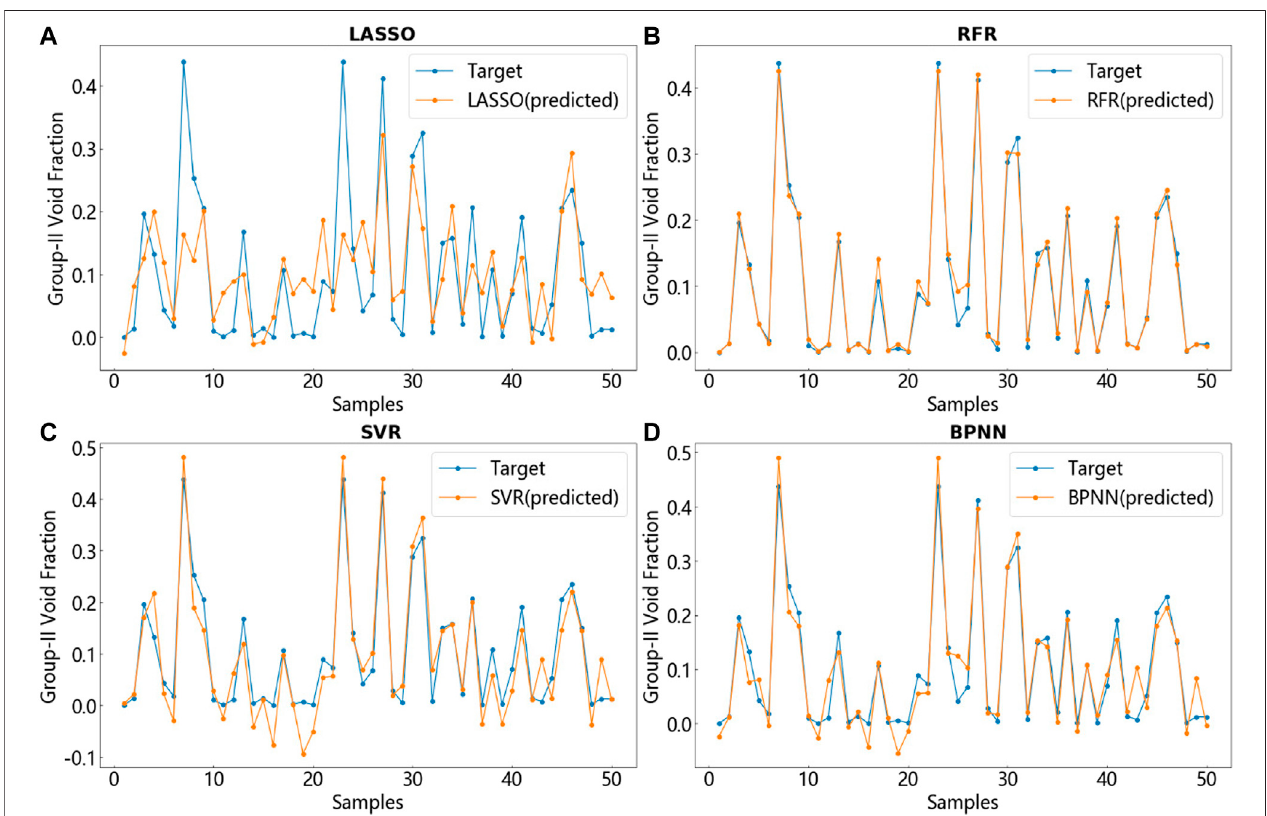
FIGURE 10 | Prediction of the group-II void fraction using four models and comparison with target values. (A) LASSO. (B) RFR. (C) SVR (D) BPNN.